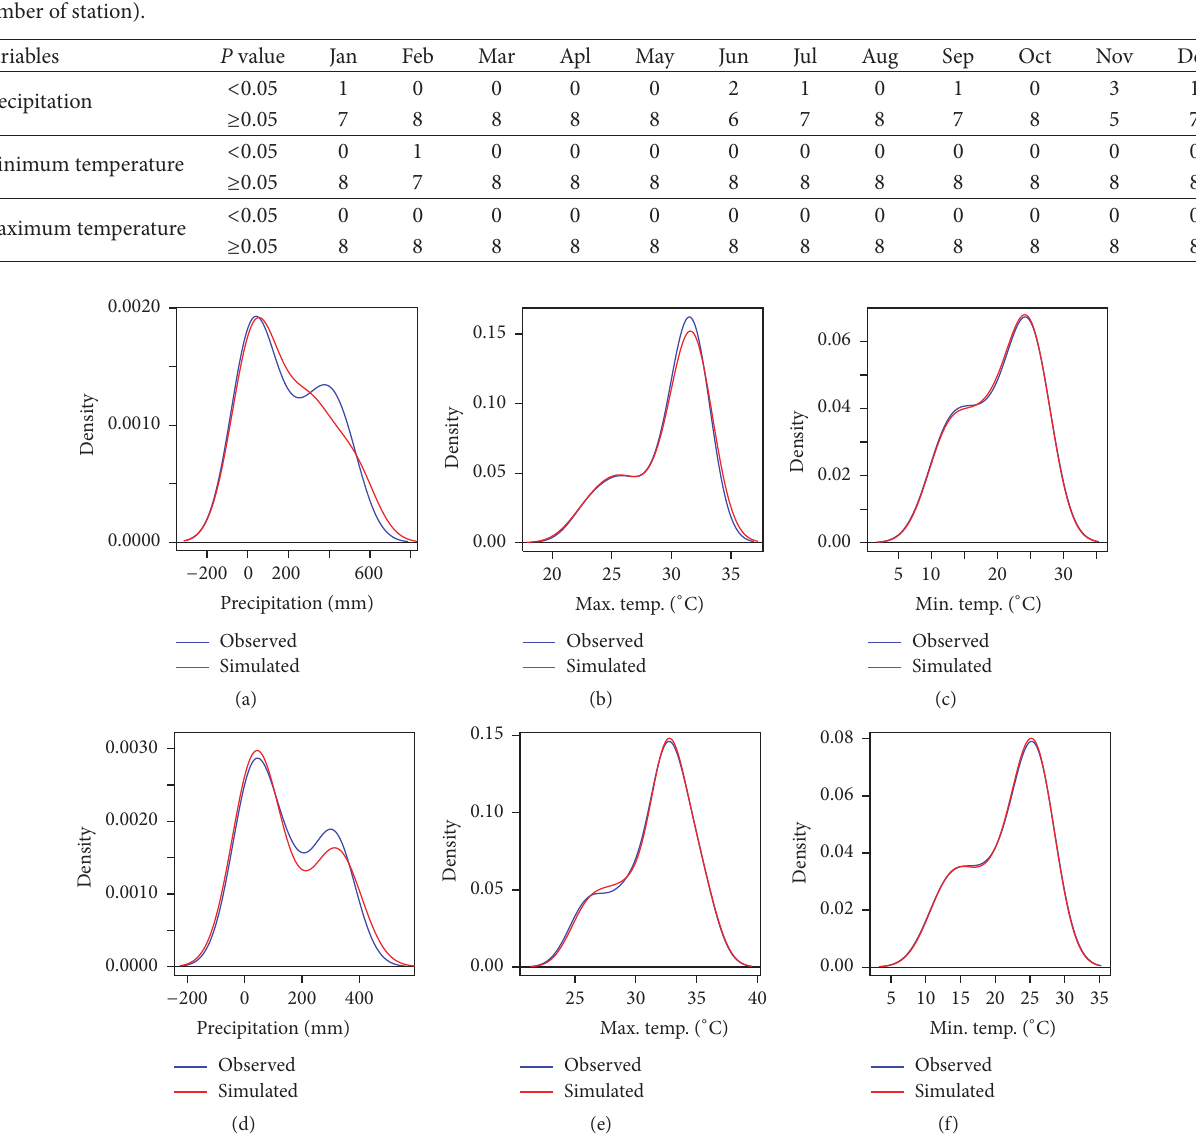
Figure 3: Comparison of observed and simulated climate variables in the paddy growing season. (a–c) show precipitation and maximum and minimum temperature in Rangpur subregion, northwestern Bangladesh; (d–f) represent precipitation and maximum and minimum temperature in Satkhira subregion, southwestern